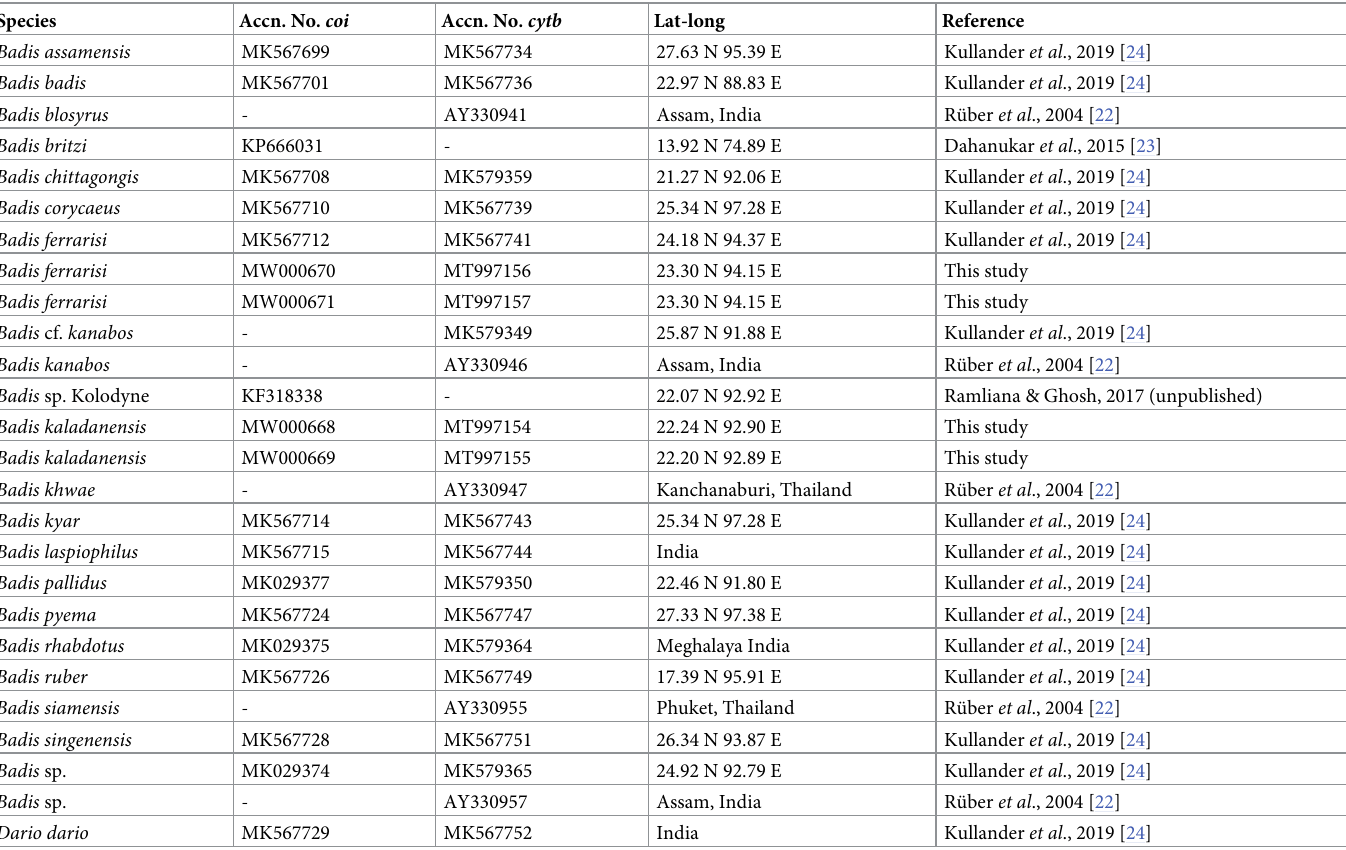
Table 2. Collection localities/ sources, voucher ID and GenBank accession numbers for taxa included in this study for coi and cytb dataset.